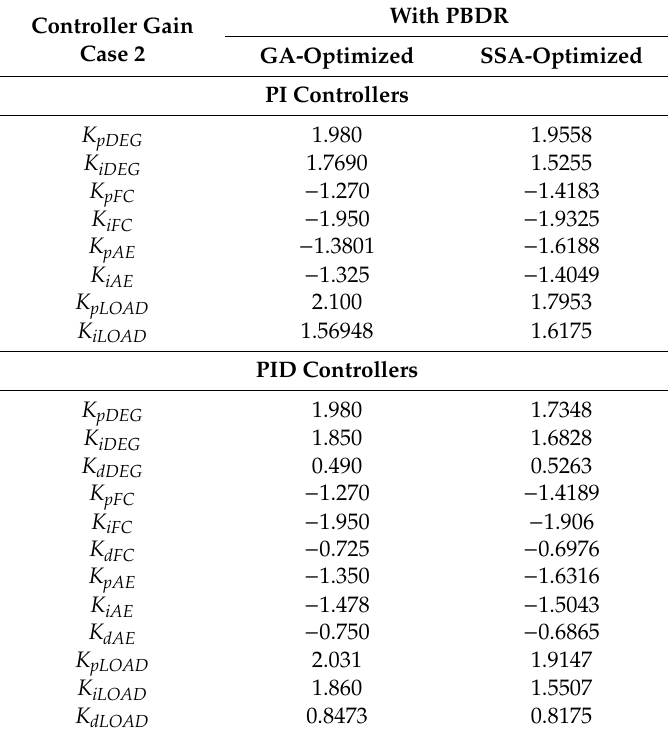
Table 5. GA- and SSA-optimized controller gain values for Case